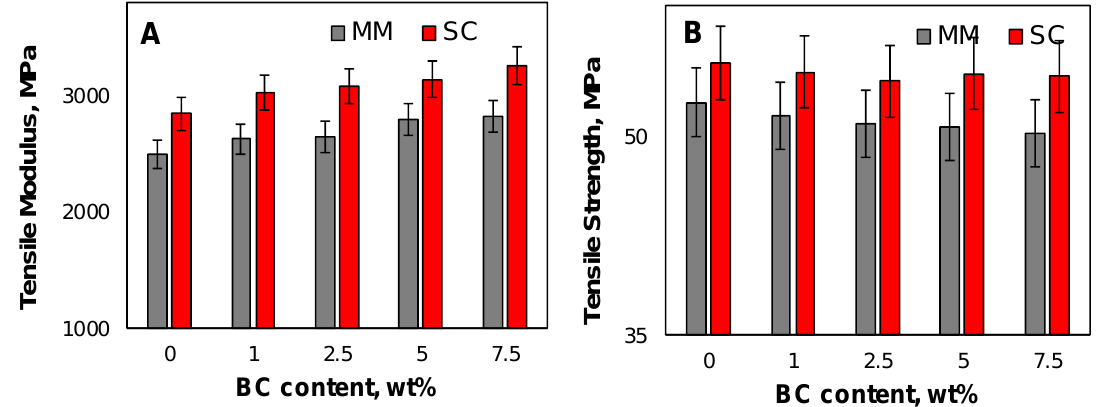
Figure 7. Tensile modulus ( A ) and tensile strength ( B ) for all investigated systems.